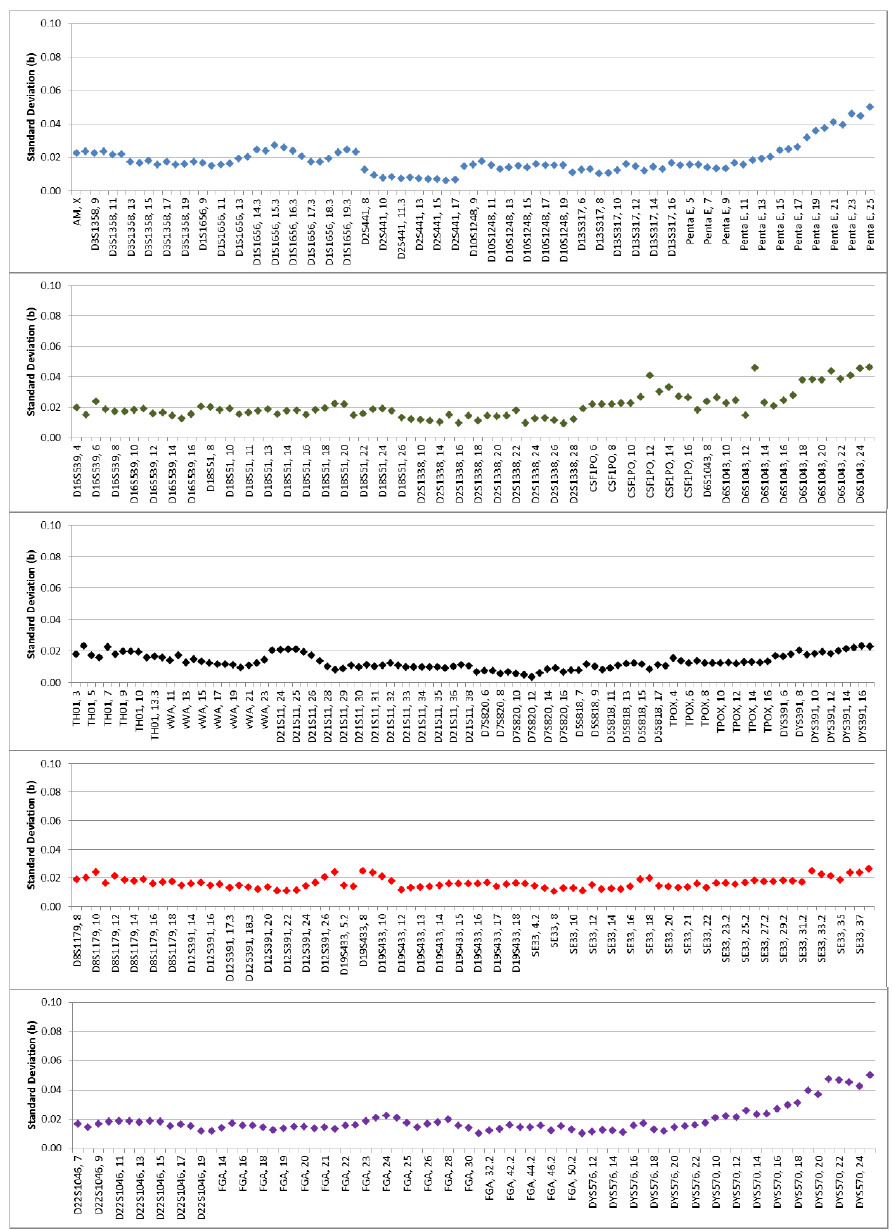
Figure 3. Inter run precision.